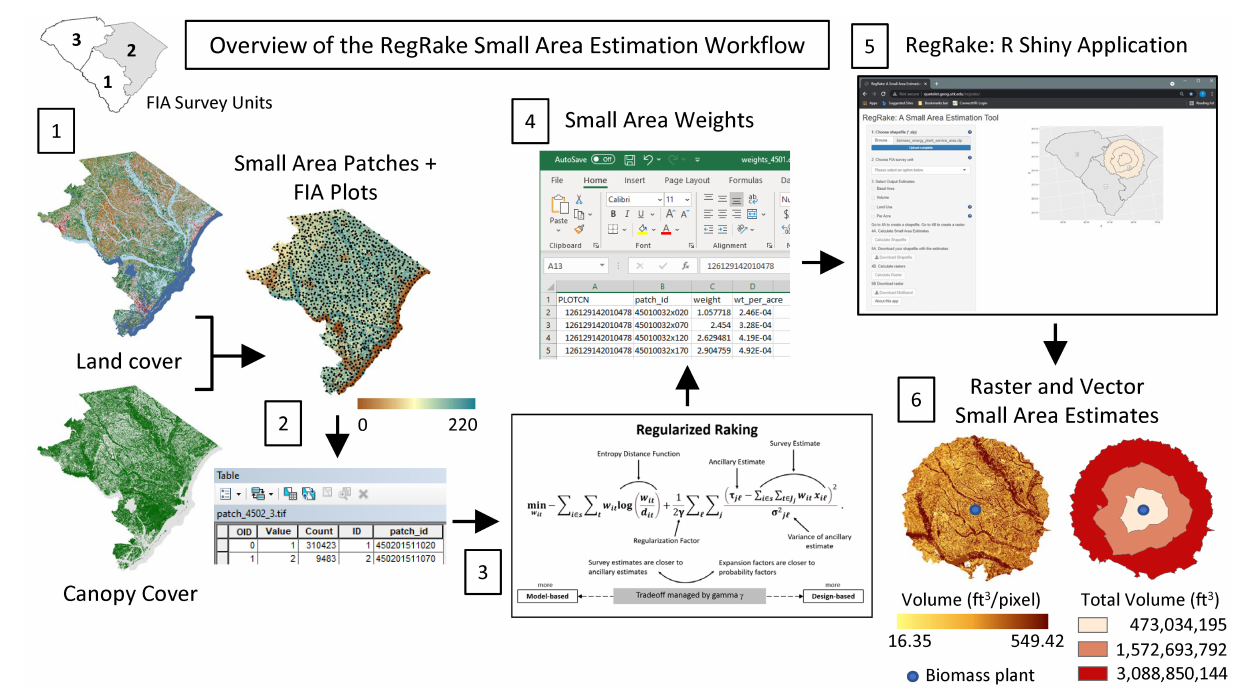
FIGURE 1 | Overview of the six main steps in the RegRake small area estimation workflow, which include: 1. Combining maps of land cover and canopy cover to produce small area patches; 2. Assigning FIA plot identifiers to the small area patches; 3. Running the regularized raking algorithm; 4. Developing a table of small area expansion factors; 5. Using the RegRake application to combine small area patches and small area expansion factors for user supplied GIS shapefile; and 6. Outputting small area estimates in raster and vector